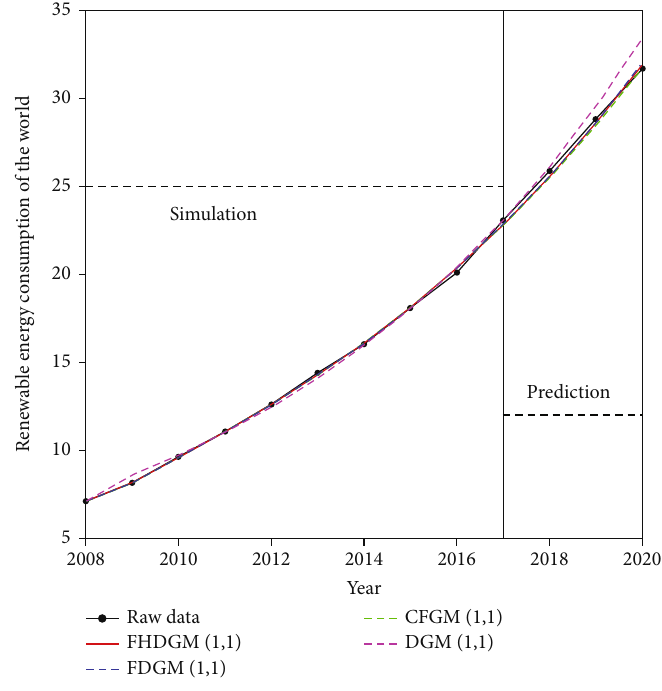
Figure 10: Fitted and predicted values of world renewable energy consumption.